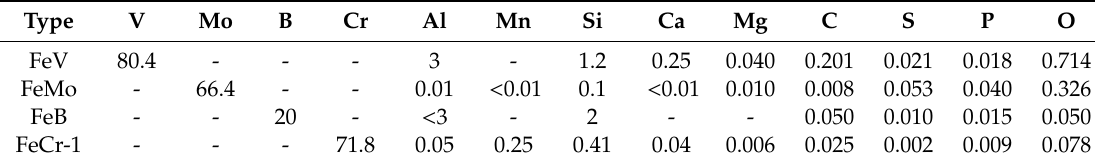
Table 1. Typical compositions of ferroalloys investigated in this study